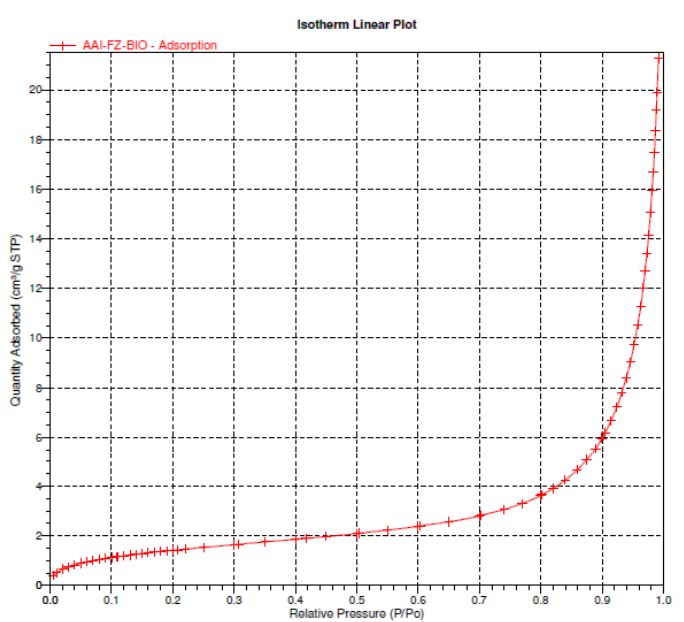
Figure 6. Adsorption isotherm of the prepared biochar.